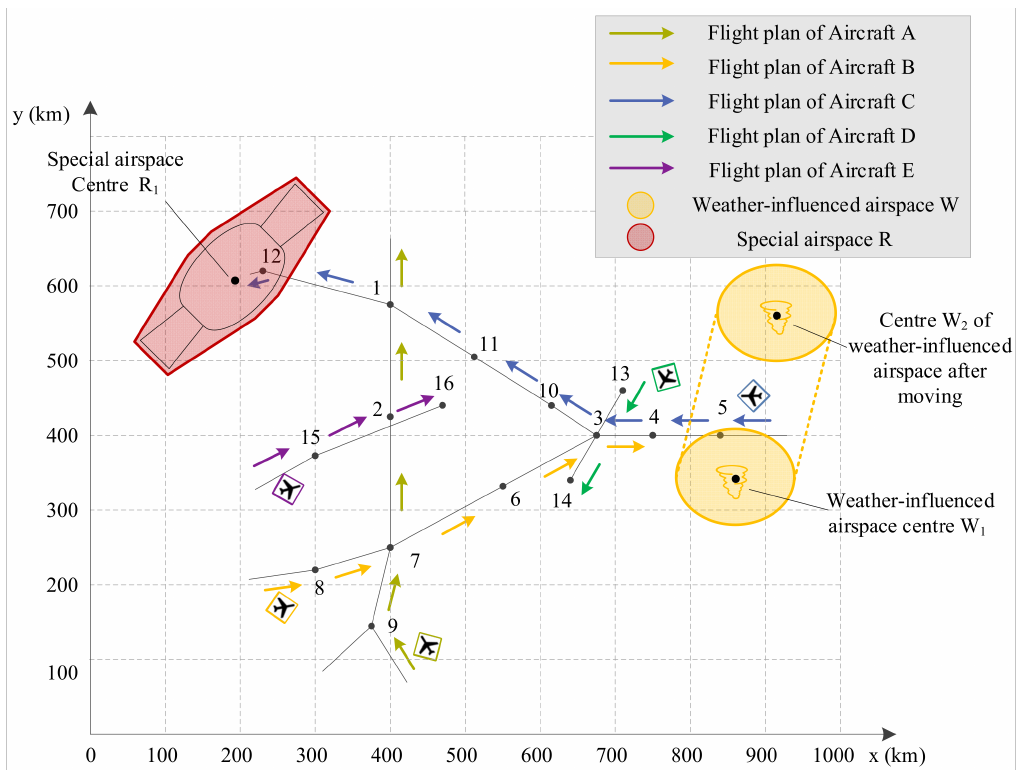
Figure 8. Airspace waypoint configuration and flight plan (The numbers represent the waypoints of the individual routes). Table 1. Airspace configuration parameters.